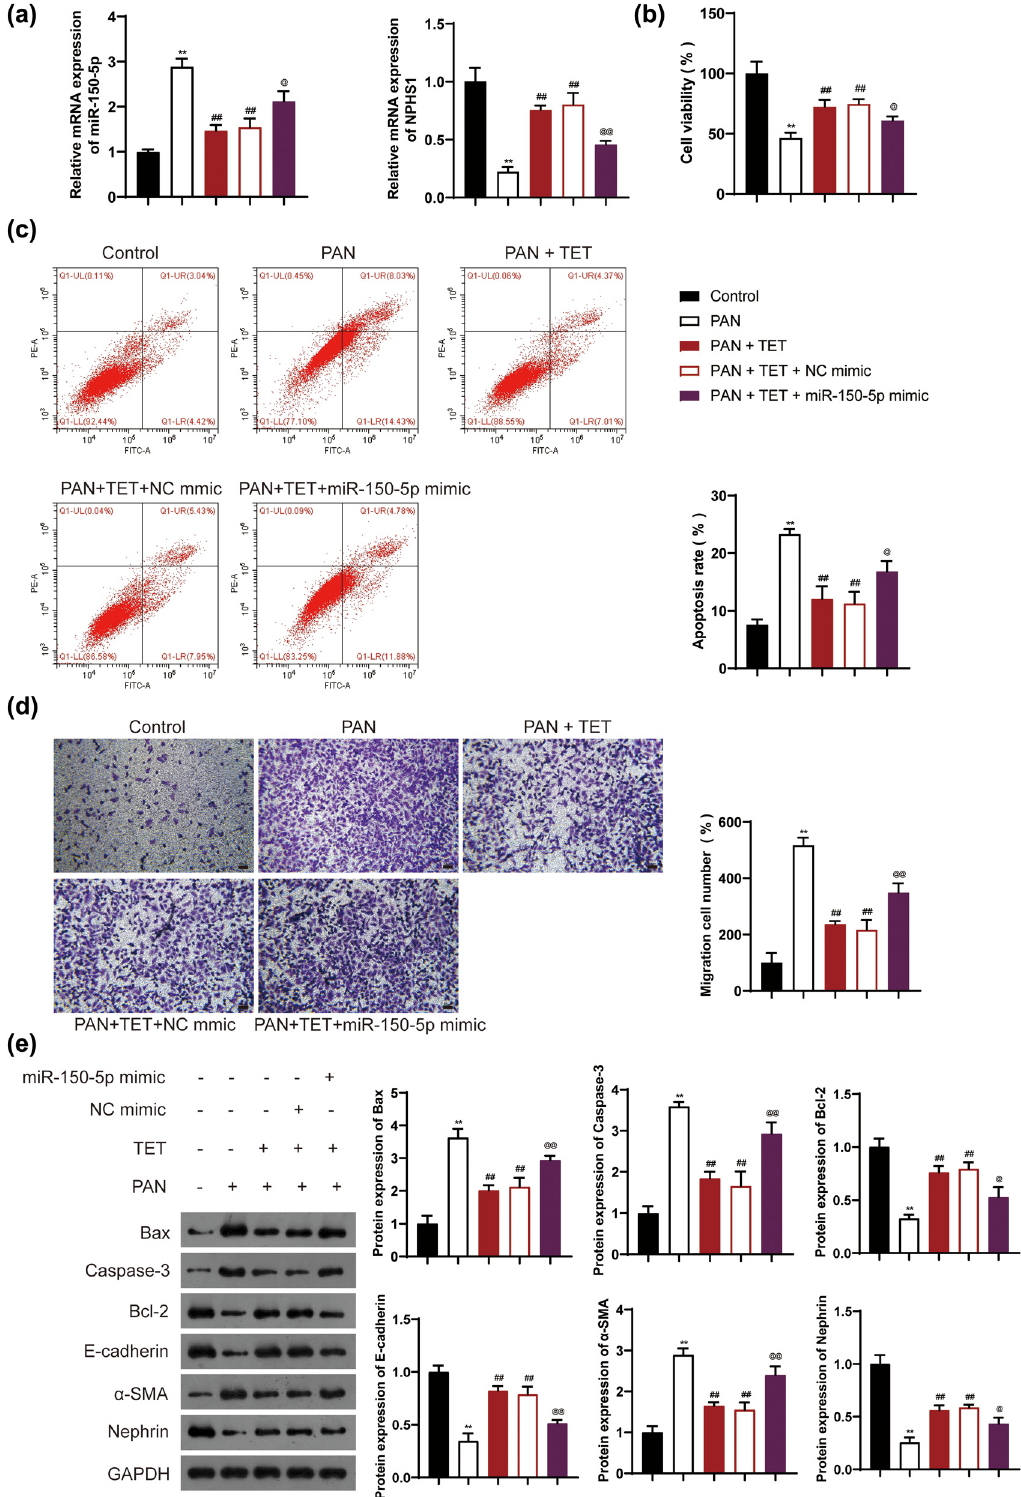
Figure 3: TET prevented podocyte injury through the miR - 150 - 5p/NPHS1 axis. ( a ) RT - qPCR detected the expression of miR - 150 - 5p and NPHS1. ( b – d ) CCK - 8, fl ow cytometry, and Transwell assays detected the cell proliferation, apoptosis, and migration, respectively; scale bar = 50 μ m. ( e ) Western blot detected the level of Bax, Bcl - 2, Caspase - 3, E - cadherin, α - SMA, and Nephrin. PAN - induced HPC were treated with 12.5 μ g/mL TET and transfected with miR - 150 - 5p mimics or NC mimics. ** P < 0.01 vs control group. ## P < 0.01 vs PAN group; @ P < 0.05, @@ P < 0.01 vs PAN + TET + NC mimic